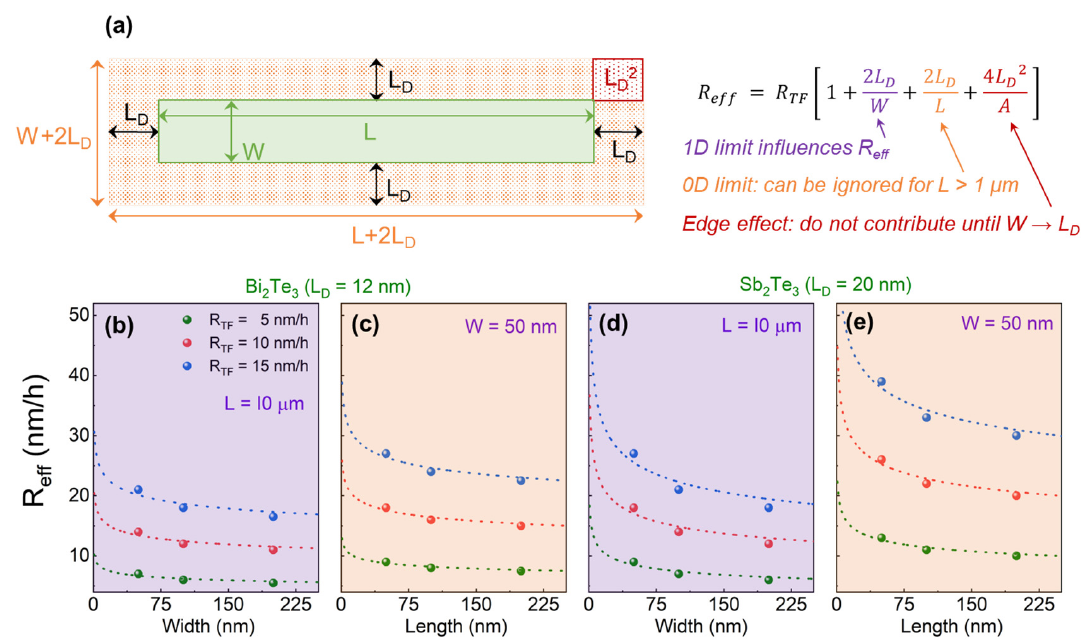
Figure 4. Selective growth model for calculating R eff . ( a ) A model representation explaining the impact of lateral diffusion length of adatoms ( L D ) on R eff , where a trench with a given surface area ( A = W × L ) experiences the effective influx of adatoms from an area of A ef f = ( W + 2 L D )( L + 2 L D ) . Evaluation of L D for Bi and Sb adatoms from the measured and fitted values of R eff for different applied R TF , i.e., 5 nm/h, 10 nm/h and 20 nm/h represented by green, red and blue data points, respectively, are shown in ( b – e ). The effects of trench width on resulting R eff values for both Bi 2 Te 3 and Sb 2 Te 3 can be seen in ( b , d ). The measured values of R eff are represented by the color dots, while the dotted lines in the corresponding colors represent fitting according to the Equation (2) with L D = 11.9 nm and 19.8 nm for Bi and Sb, respectively. The drastic enhancement in R eff with continually decreasing L of the structure while W is kept constant at 50 nm for ( c ) Bi 2 Te 3 and ( e ) Sb 2 Te 3 . Here, the fitting is achieved according to Equation